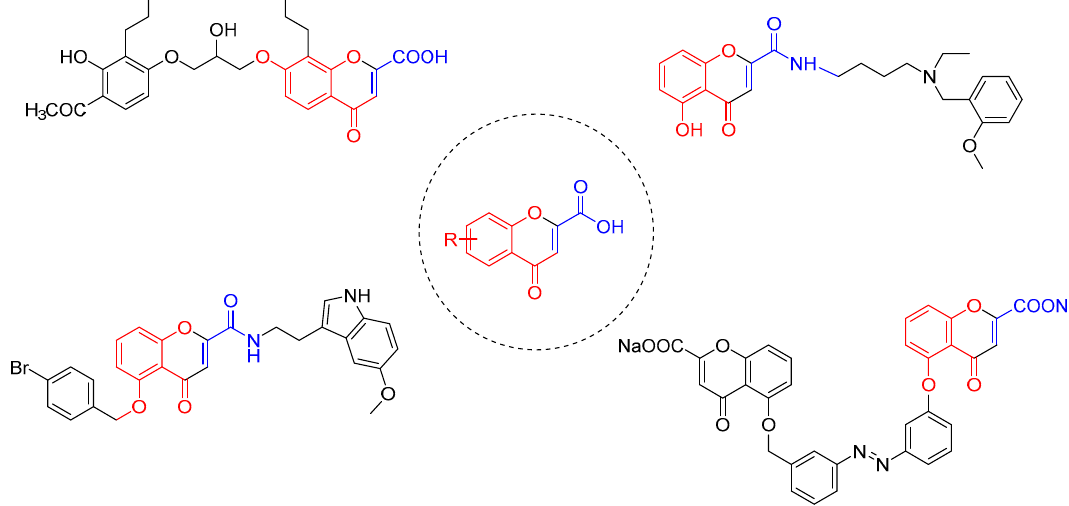
Figure 2. Chromones obtained from 4-oxo-4 H -chromene-2-carboxylic acid with relevant biological activity [1,2].